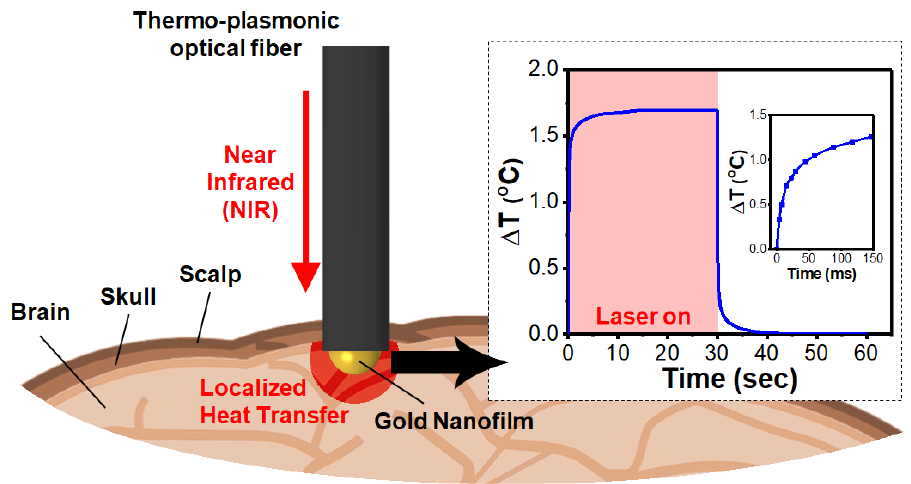
Figure 1. Schematic illustration of in vivo photothermal stimulation by a thermoplasmonic optical fiber. The inset image shows the temperature changes by the thermoplasmonic optical fiber.